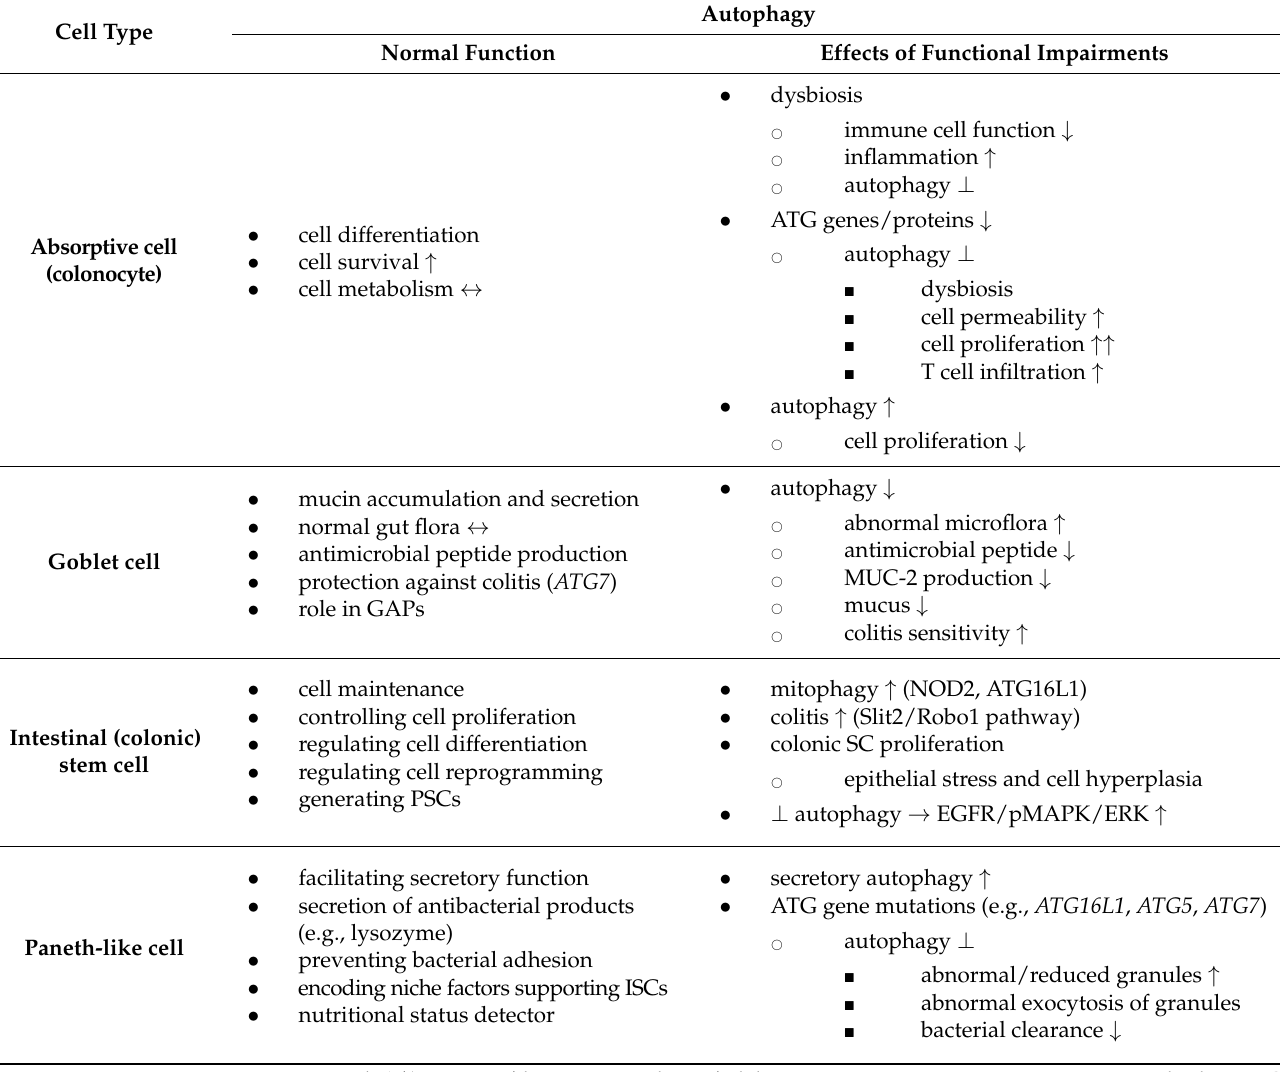
Table 1. Cell-specific normal and impaired functions of autophagy in the colonic epithelial cells. Cell